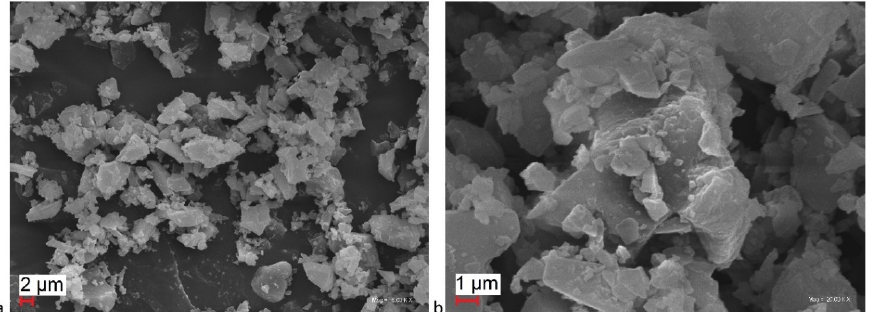
Figure 2. Structure of used biocarbon ( a ) magnification 6000 × , ( b ) magnification 20000 × .